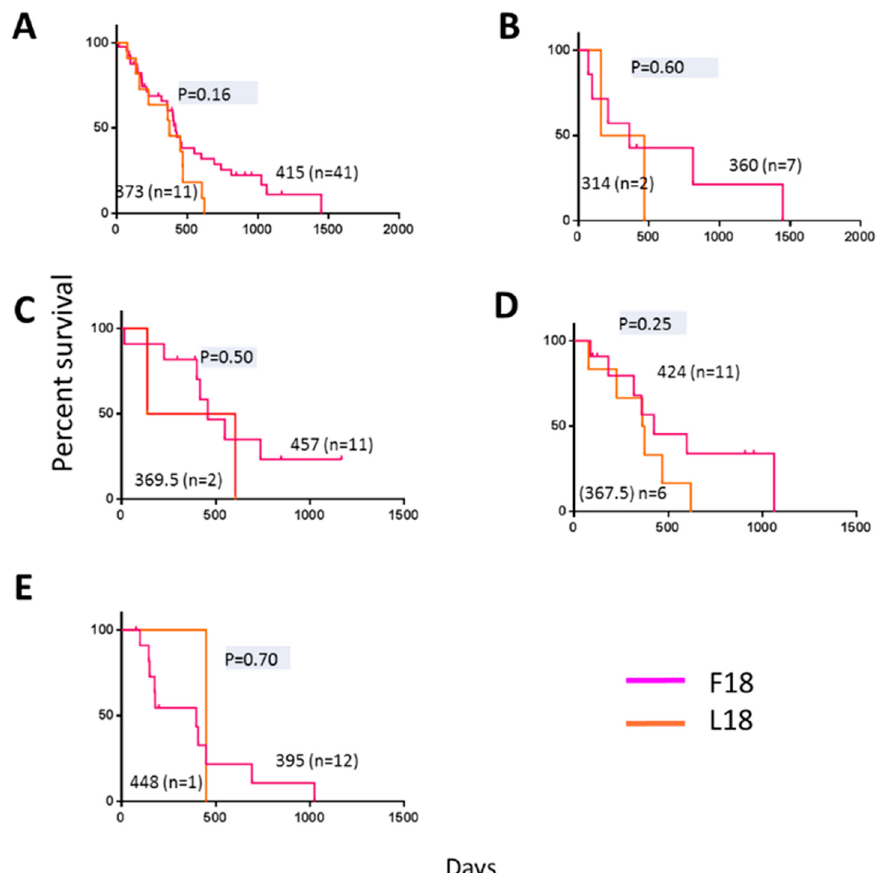
Figure 4. Kaplan-Meier estimates of overall survival in 52 primary adult glioblastoma patients present in the cancer genome atlas (TCGA) database previously assigned a gene expression subtype [5] and stratified based on F18L status (this study). The overall median survival for F18L-carriers are shown in magenta and non-carriers in orange for ( A ) all subtypes analysed together, and ( B ) classical, ( C ) neural, ( D ) mesenchymal, and ( E ) pro-neural subtypes. Horizontal dashes denote censored points, and median overall survival for all groups (no brackets), the number of patients in each group (brackets), and p -values (grey) are also indicated.